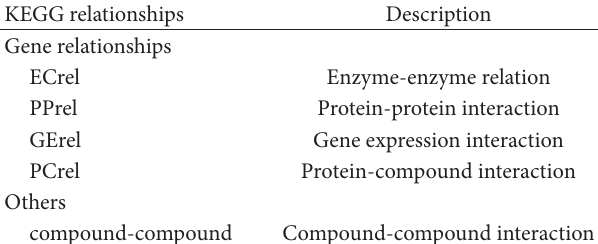
Table 1: Possible interactions presented in KEGG are classified into two groups, gene relationships and others relationships. First the four types of gene relationships are